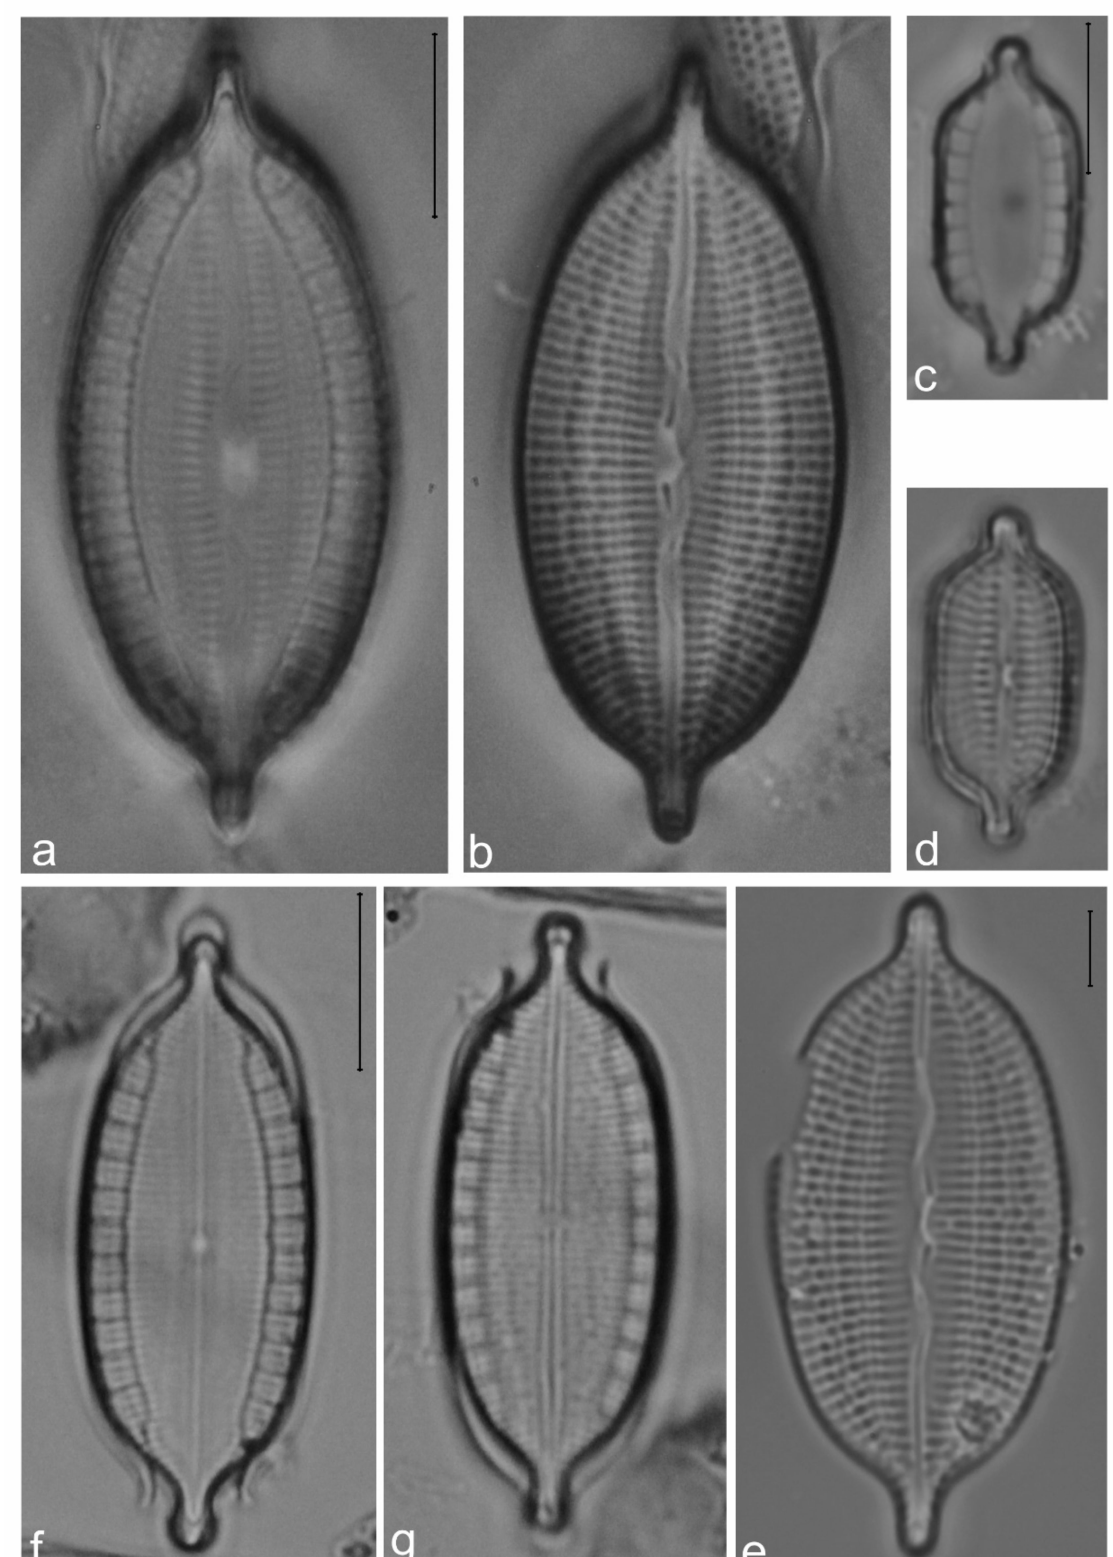
Figure 24. ( a – e ) Mastogloia corsicana in different focal planes and showing a range in size; ( f , g ) M . ignorata . Scale bar = 10 µ